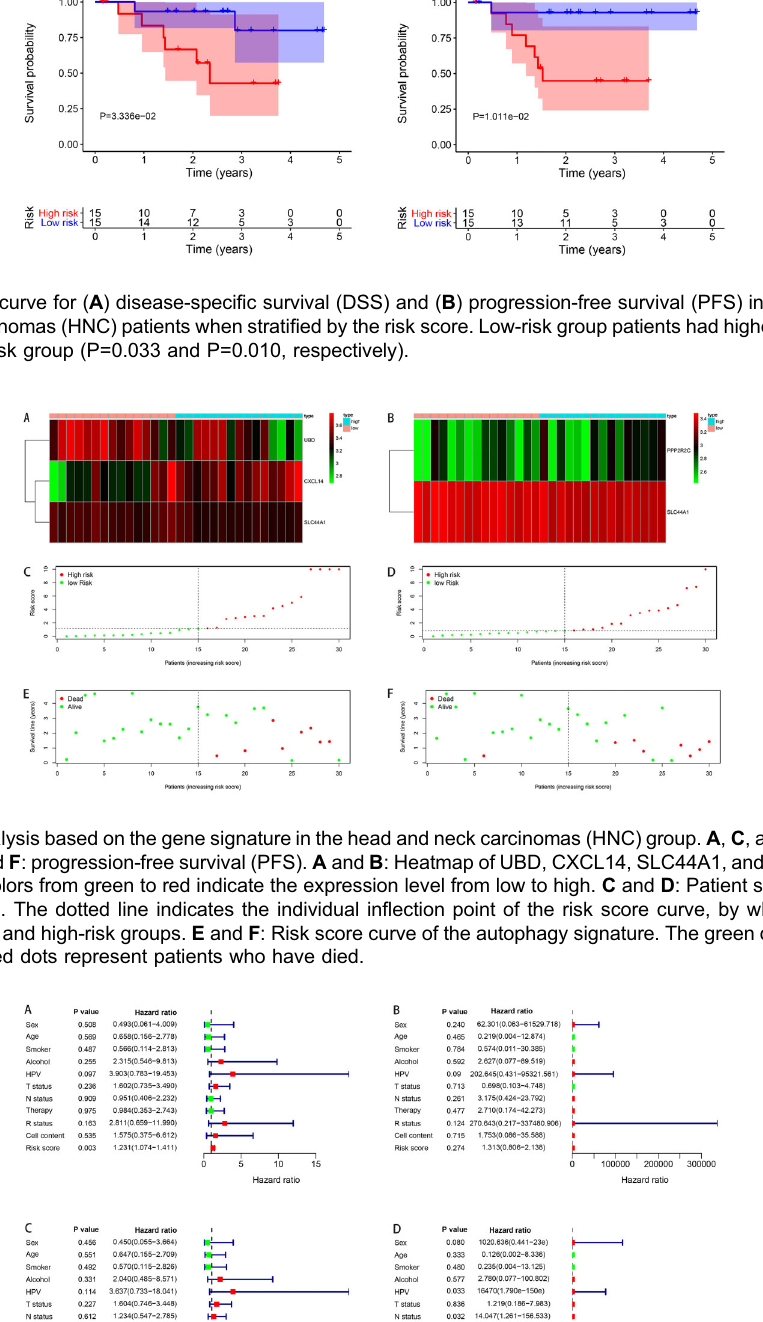
Braz J Med Biol Res | doi: